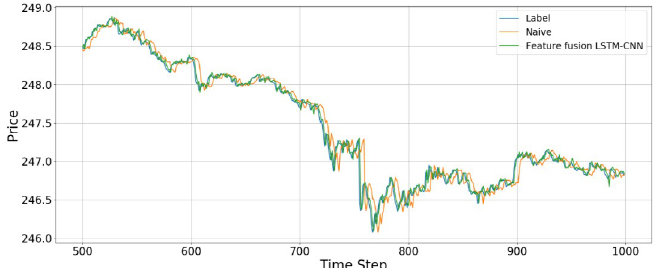
Fig 16. An example of predicting stock prices using the feature fusion LSTM-CNN model with a test dataset of between 500 and 1,000 data points. The input data are candlebar chart and stock time